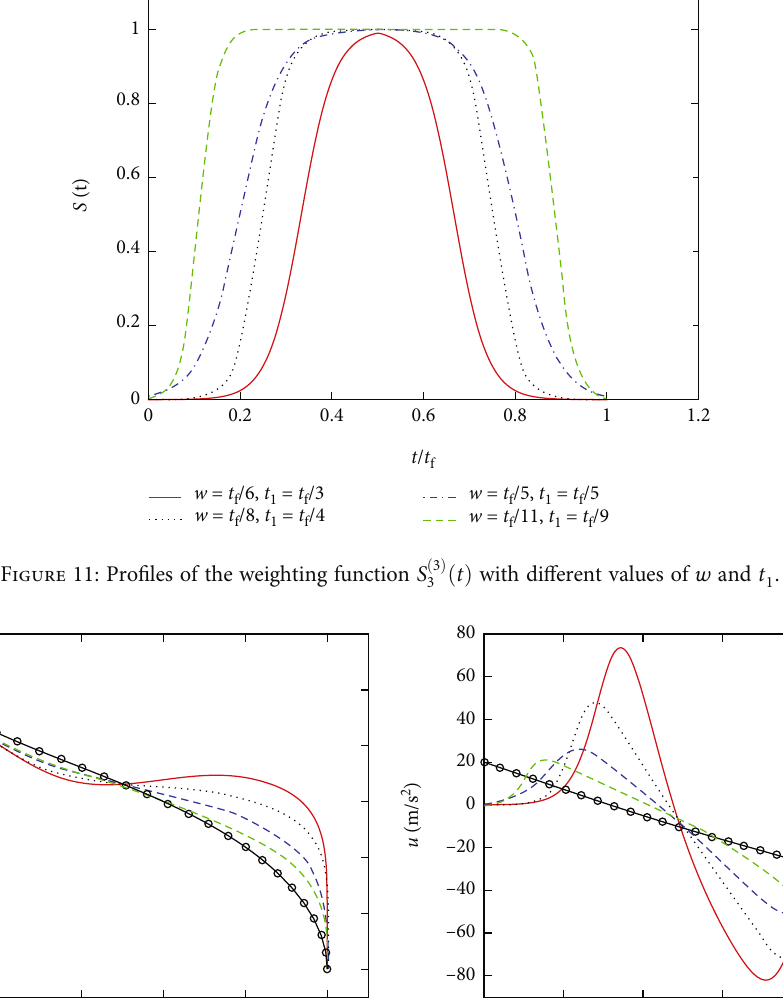
Figure 12: The comparison results of weighting functions S ð 3 Þ